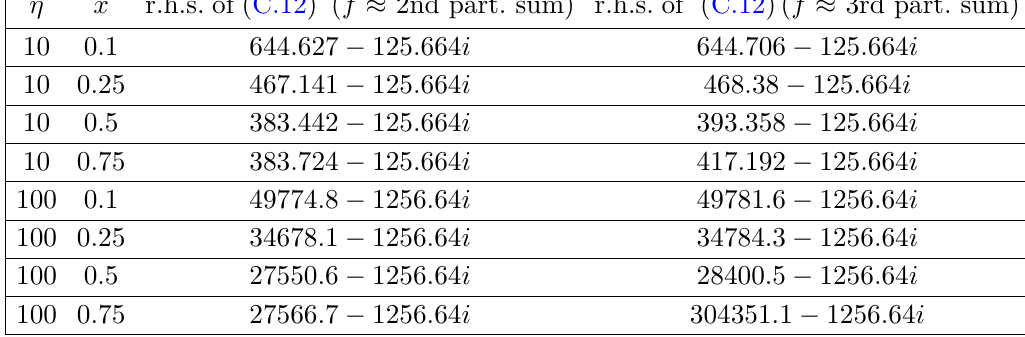
Table 1 . Some numerical values of the right hand side of the relation